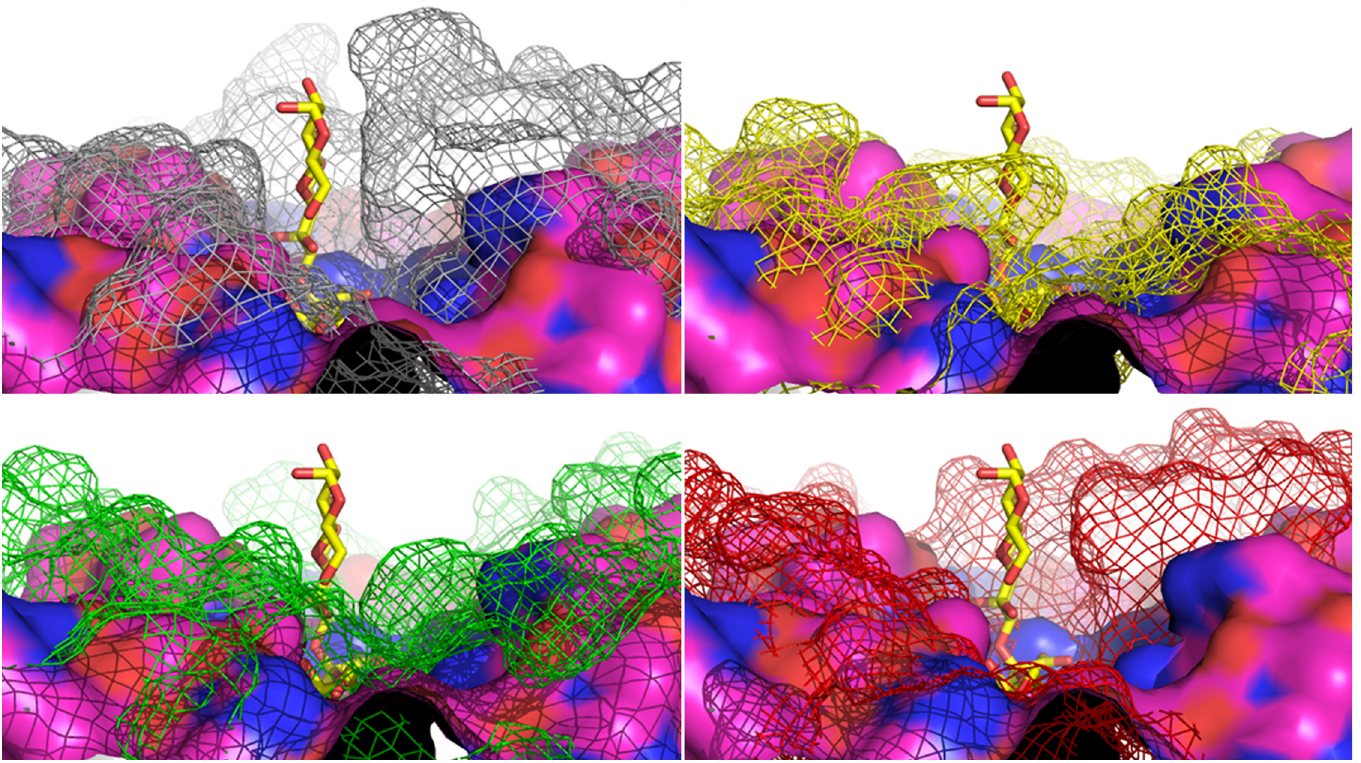
Fig 3. Alignment of the surface around the active site of sialidase from Micromonospora viridifaciens (MvSA) to TcTS and three native sialidases with limited trans-sialidase activity. The surface around the active site of sialidase from Micromonospora viridifaciens (MvSA; magenta surface; PDB 1W8O) with no trans-sialidase activity is aligned to TcTS (gray mesh; PDB 1S0I) in Michaelis complex with 3 ’ -sialyllactose (3 ’ SL; yellow sticks), and to sialidases to limited trans-sialidase activity from Vibrio cholerae (VcSA; yellow mesh; PDB 1W0P), Clostridium perfringens (CpSA; green mesh; PDB: 2VK5) and Salmonella typhimurium (StSA; red mesh; PDB: 3SIL),